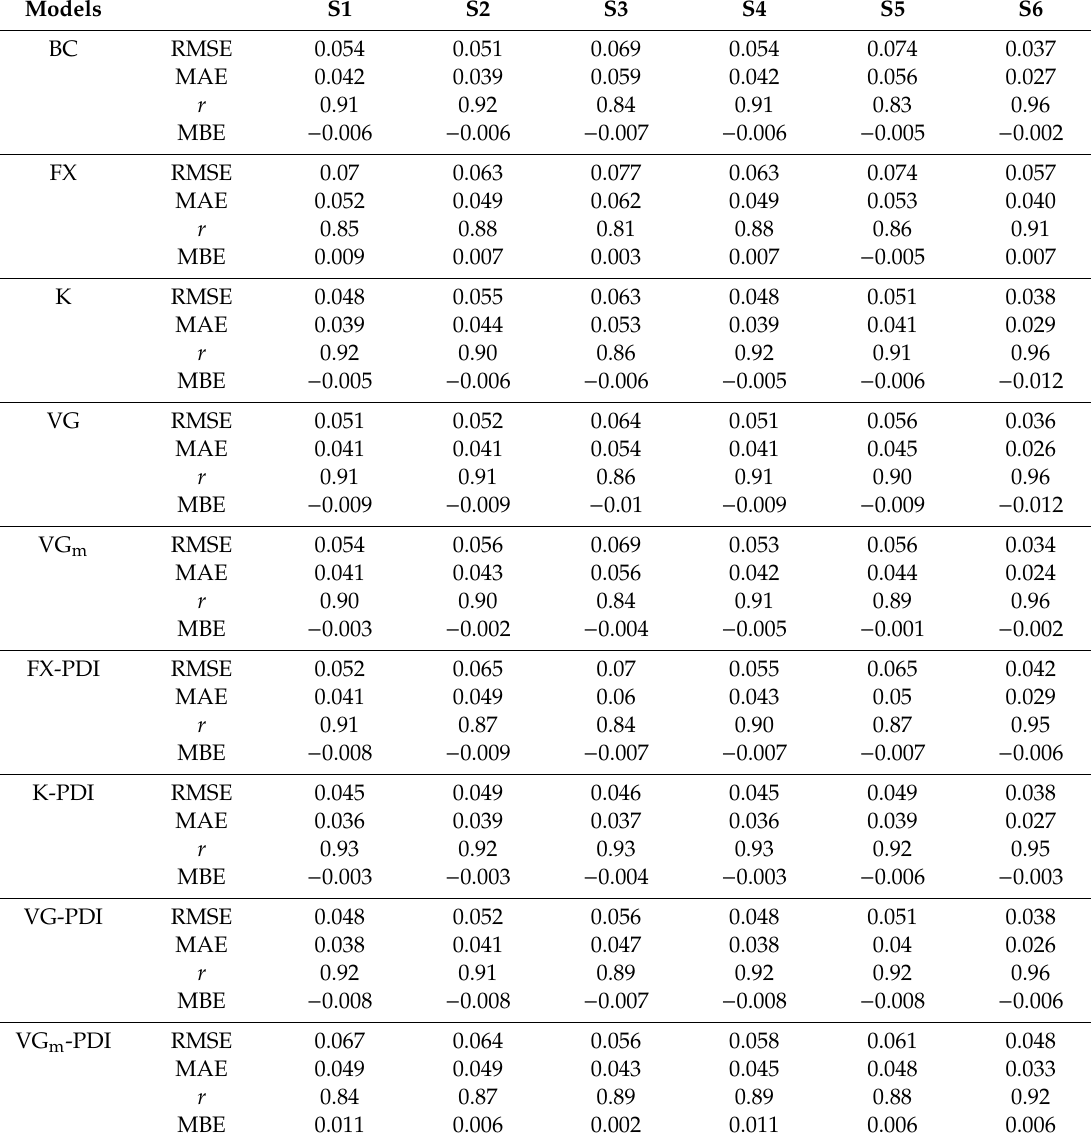
Table 4. Performance evaluation of the unimodal and unimodal-Peters–Durner–Iden (PDI) parametric PTFs for all modeling scenarios